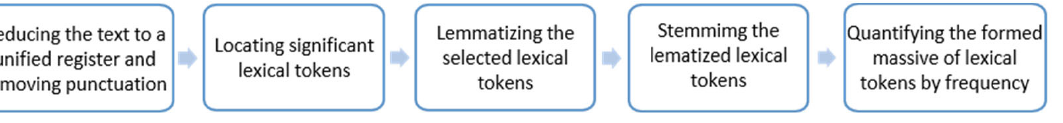
Figure 8. Tokenization algorithm.